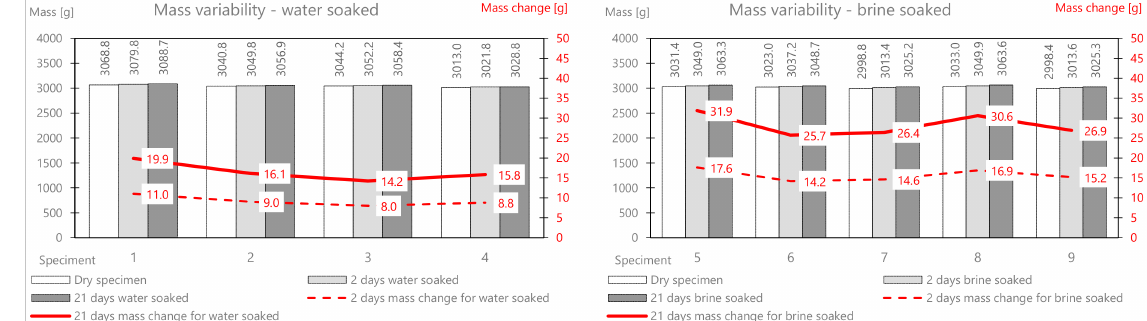
Figure 9. ACWMS22(HIMA) mix mass variability.